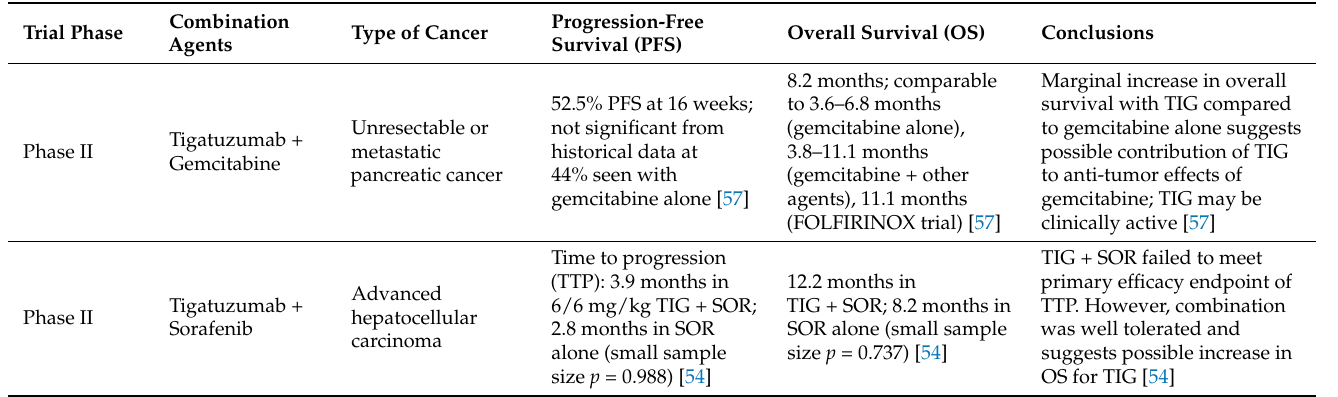
Table 3. Phase 2 clinical efficacy of Tigatuzumab (TIG) in combination with gemcitabine, sorafenib, and